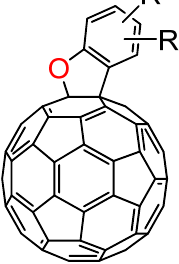
Figure 6. Molecular structure of benzo[ b ]furano[2',3':1,2][60]fullerene